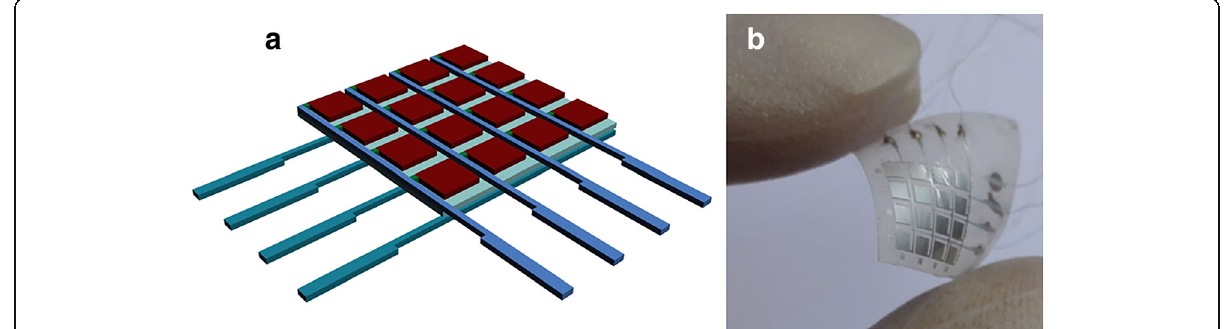
Fig. 1 a Schematic diagram of the sensor array. b Physical picture of the ultimate